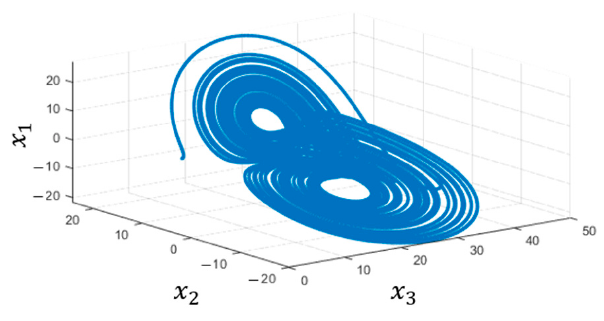
Figure 1. Strange attractor in master.